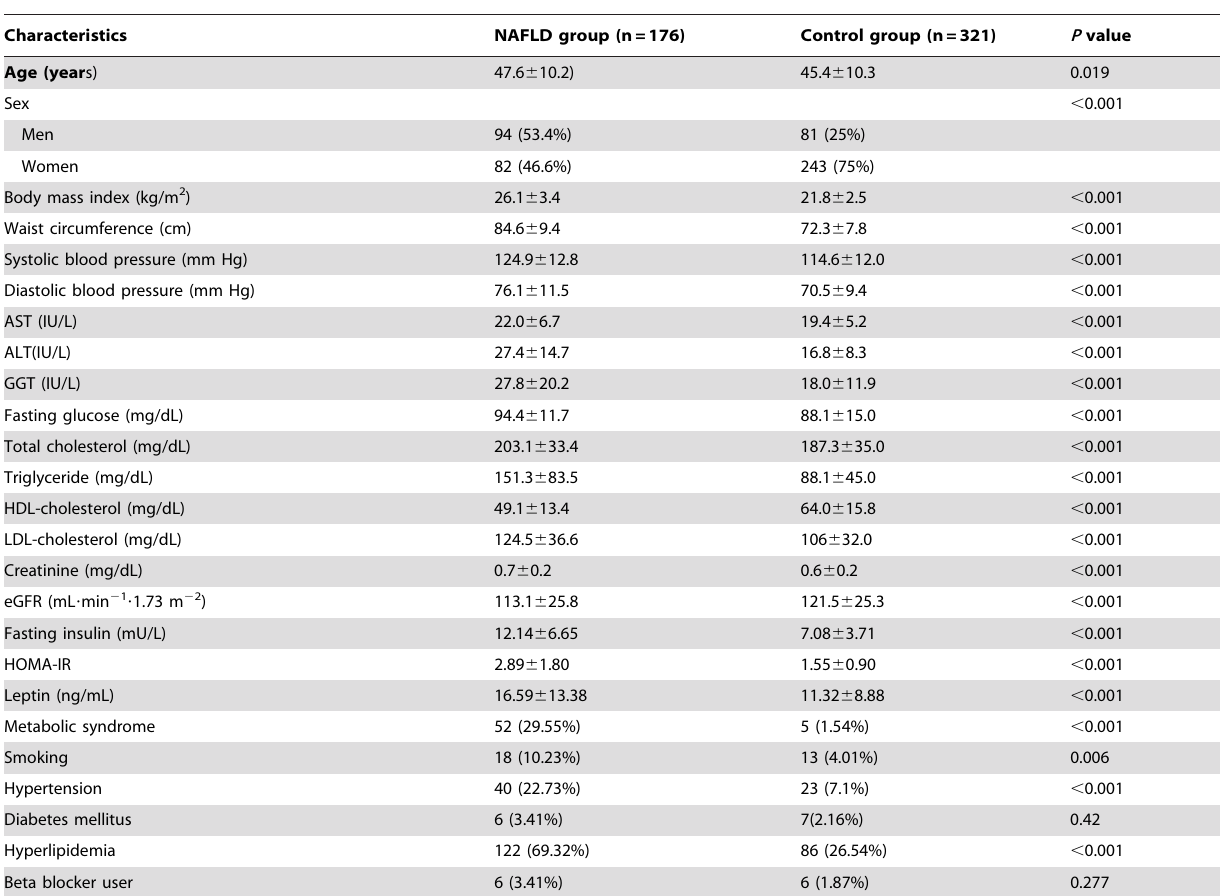
Table 1. Clinical and biochemical characteristics of participants (N =497).